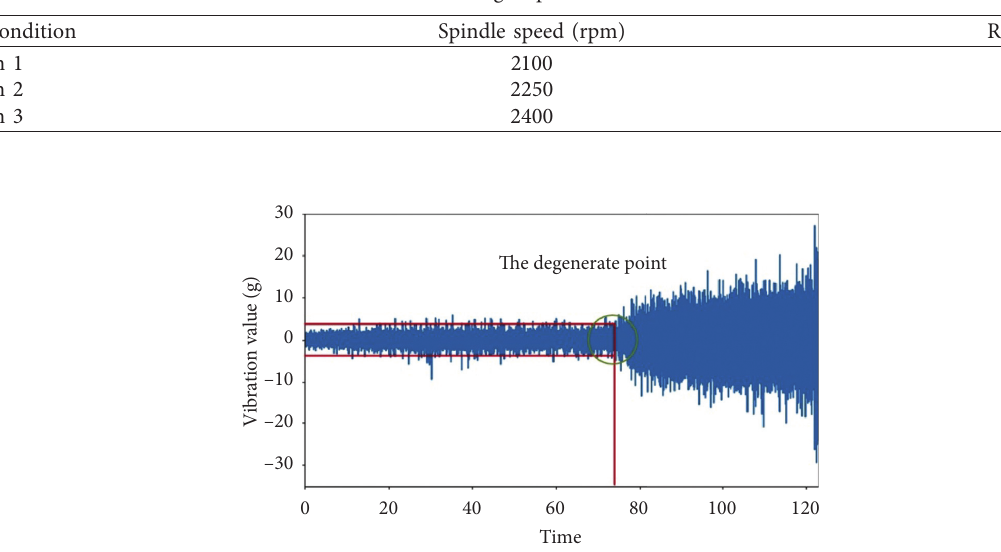
Figure 6: The life-span vibration signal of bearing